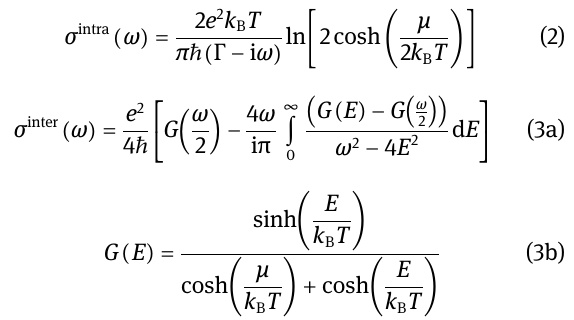
from [6]. (c) Optical conductivity of graphene, in units σ 0 = e 2 / 4 ℏ , as a function of frequency ω . The real part (Re ( σ ) , red) and the imagi- nary part (Im ( σ ) , blue) are plotted for low ( T / E F = 0 . 005, solid), and high ( T / E F = 0 . 05, dashed) temperature. The red shaded area